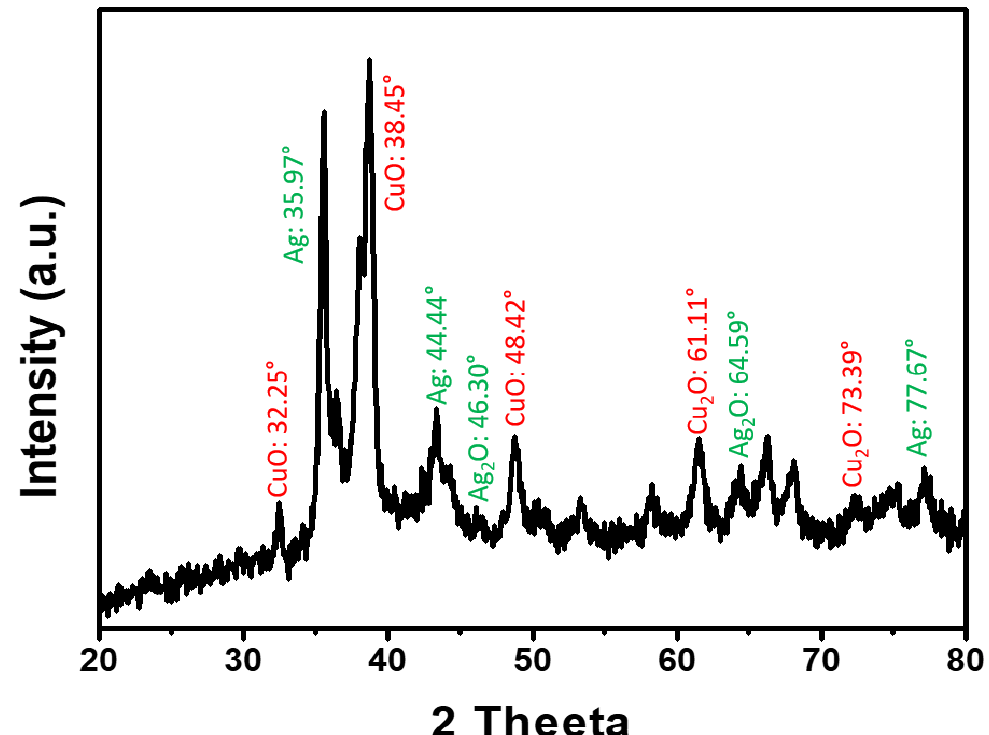
Figure 4. XRD pattern of the Ag-CuO nanohybrids.